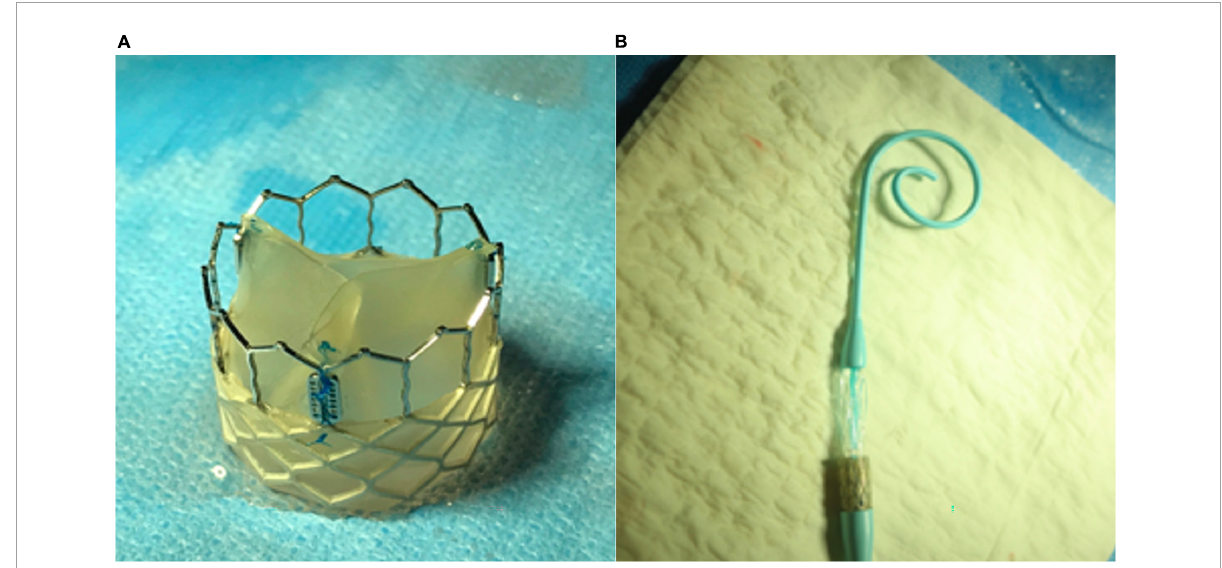
FIGURE2 A cross-section of a single leaflet was imaged using scanning electron microscopy (SEM) (mag. 8000x).